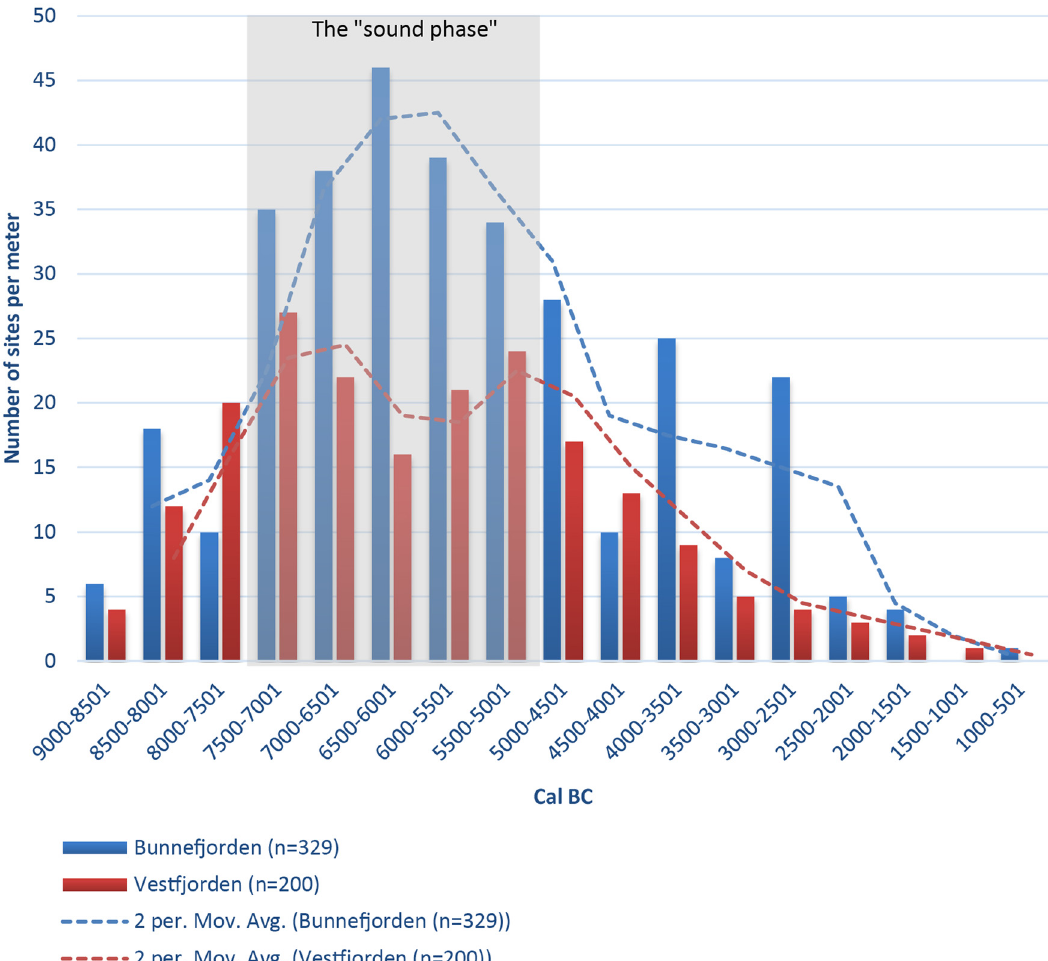
Figure 10: Number of sites in two parts of Inner Oslo Fjord distributed in 500 year intervals. The date of each site is based on the shore - level displacement